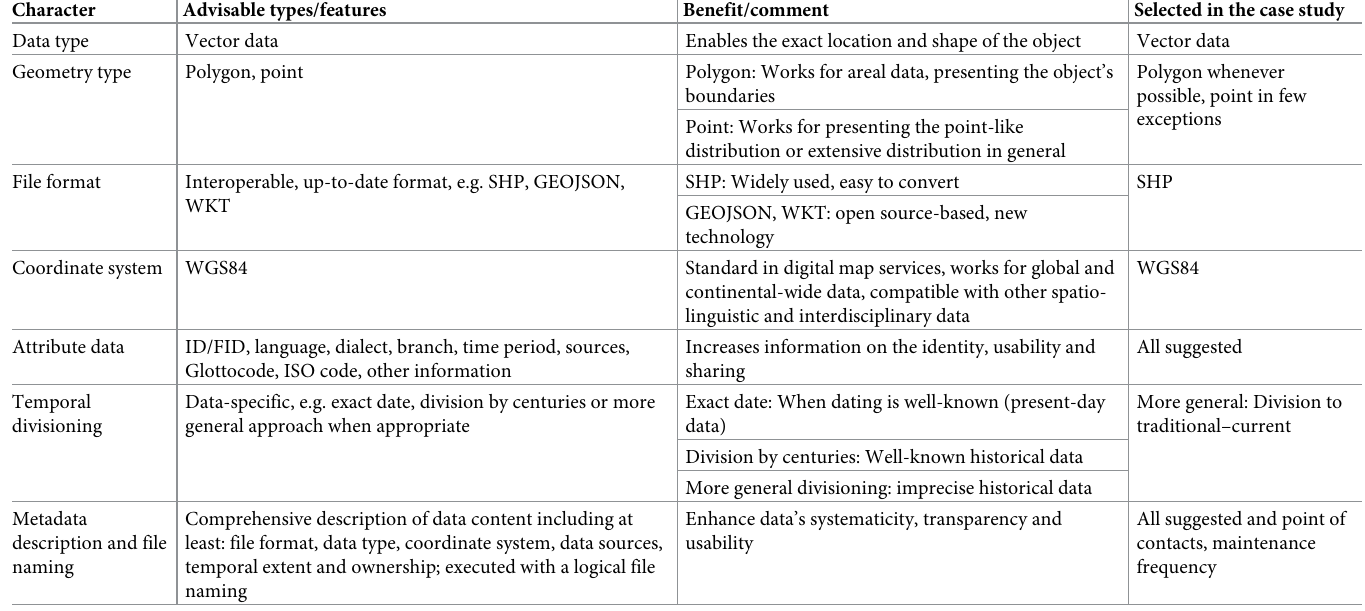
Table 1. Recommendations for the suitable contents of the geospatial datasets presenting the distribution of languages including the benefits of each, and our solu- tions (selected in the case study) concerning the Uralic